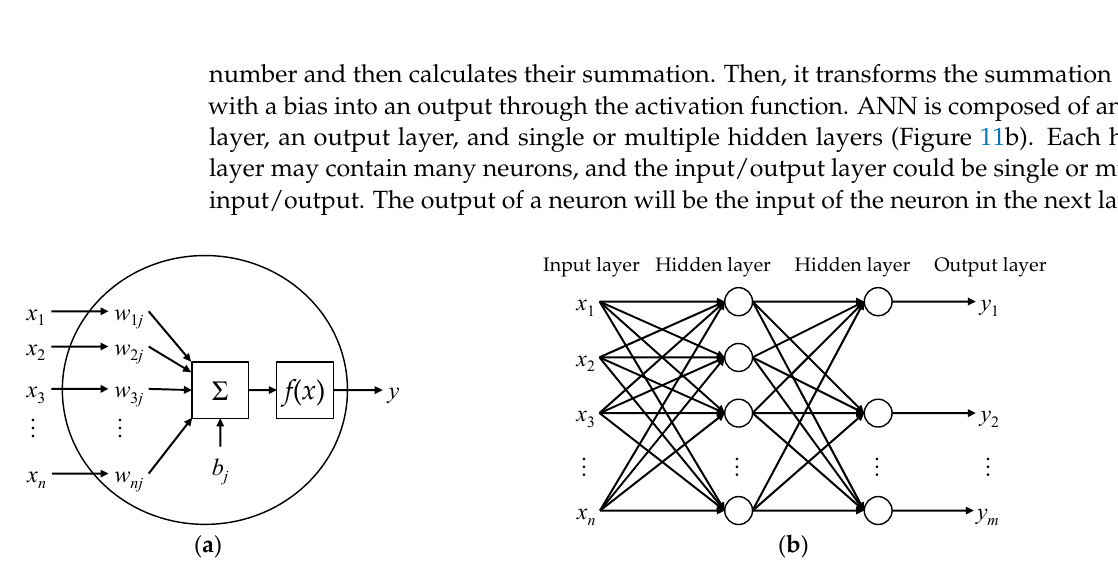
In order to calibrate the warm-up shift of the output signal of the smart tool holder, the authors use an ANN with a single hidden layer. The input of the ANN model is the time series of the output voltages of the force sensor, and the output is the applied loads. The